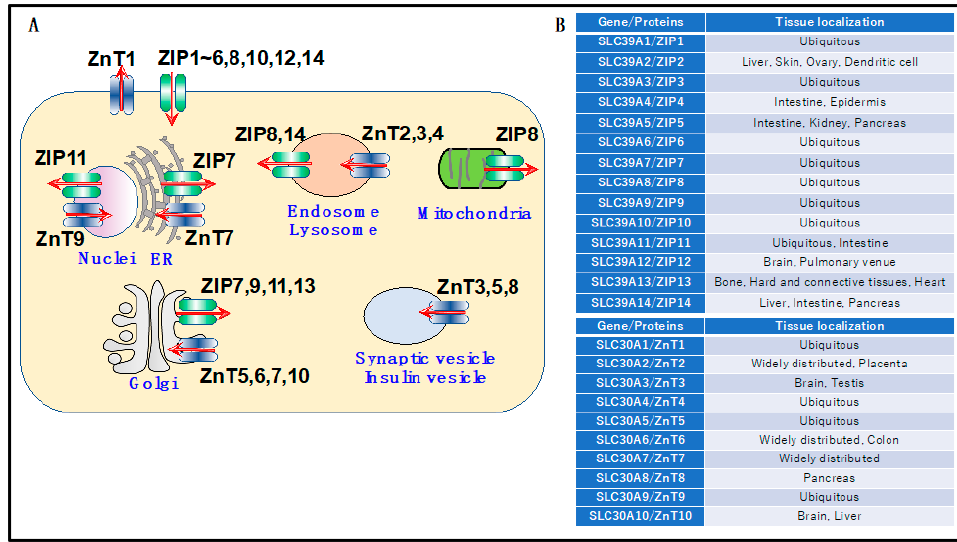
Figure 2. Schematic diagram of zinc transporter distribution in the cell ( A ) and in the tissues ( B ). Zinc transporters are expressed in organelles and cell membranes of various tissues. To maintain zinc levels in the cells, ZIP family members increase intracytoplasmic zinc concentration, and ZnT family members decrease intracytoplasmic zinc concentration.